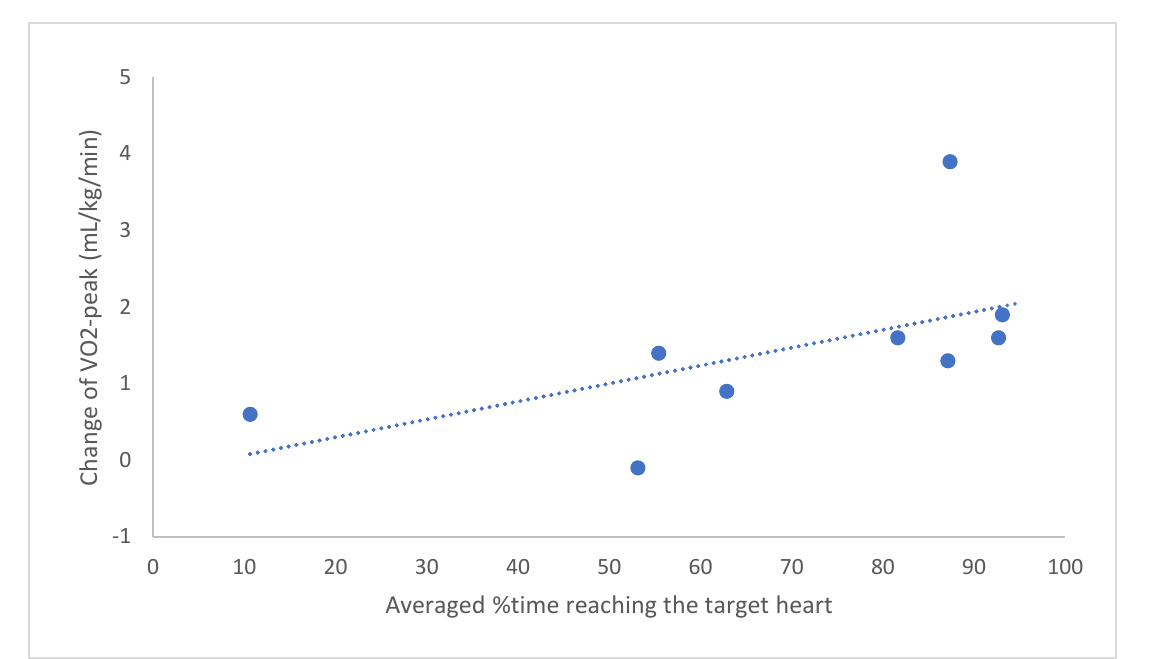
Figure 2. Correlation between adherence to training intensity and the change in aerobic capacity among 9 participants. The x -axis indicates the average %time the user’s heart rate was within the target range (60 – 80% HRR) during the 12 sessions. The y -axis indicates the change in VO 2-peak between the pre- and post-test ( rs = 0.85, p = 0.004).